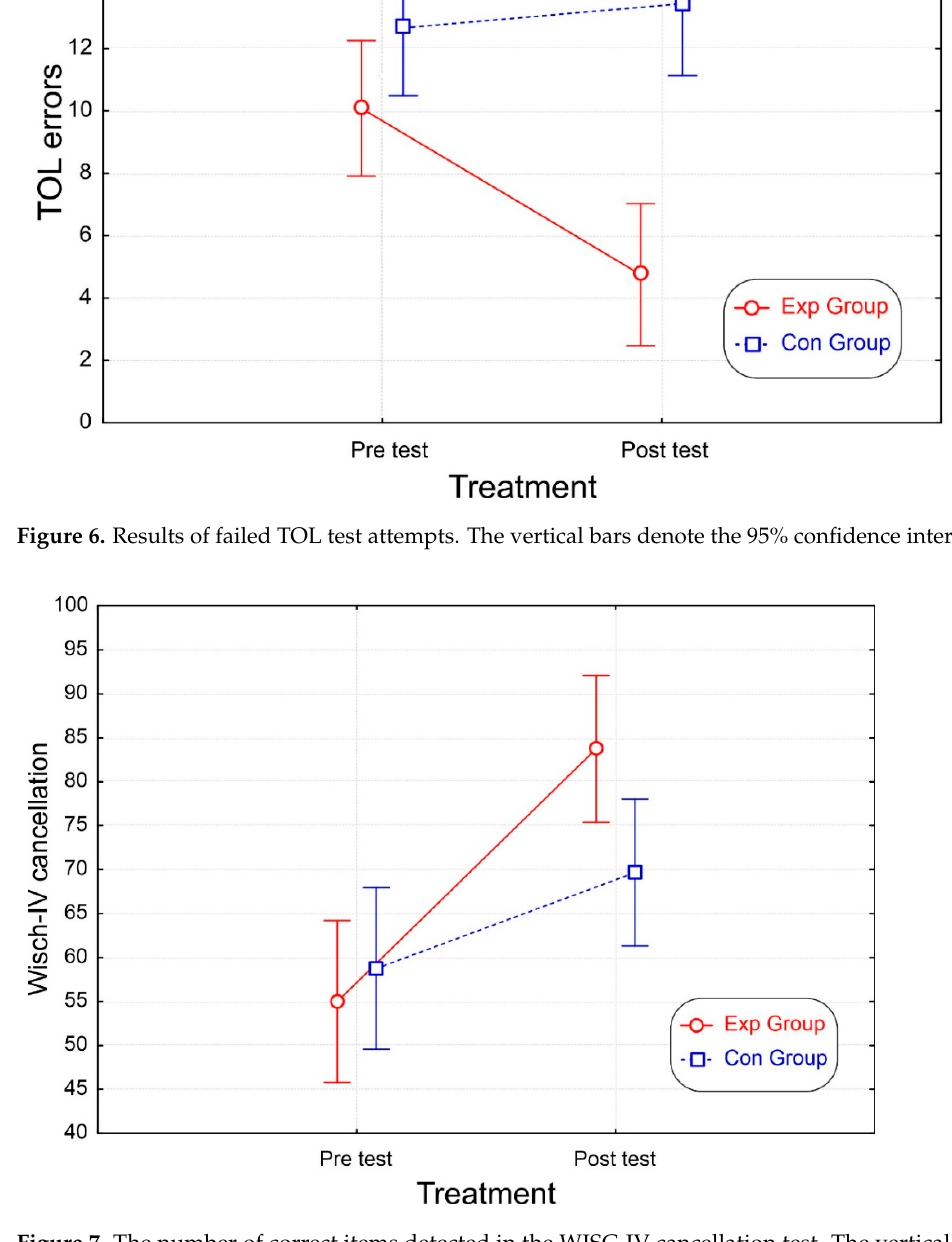
Figure 7. The number of correct items detected in the WISC-IV cancellation test. The vertical bars denote the 95% confidence interval. denote the 95% confidence